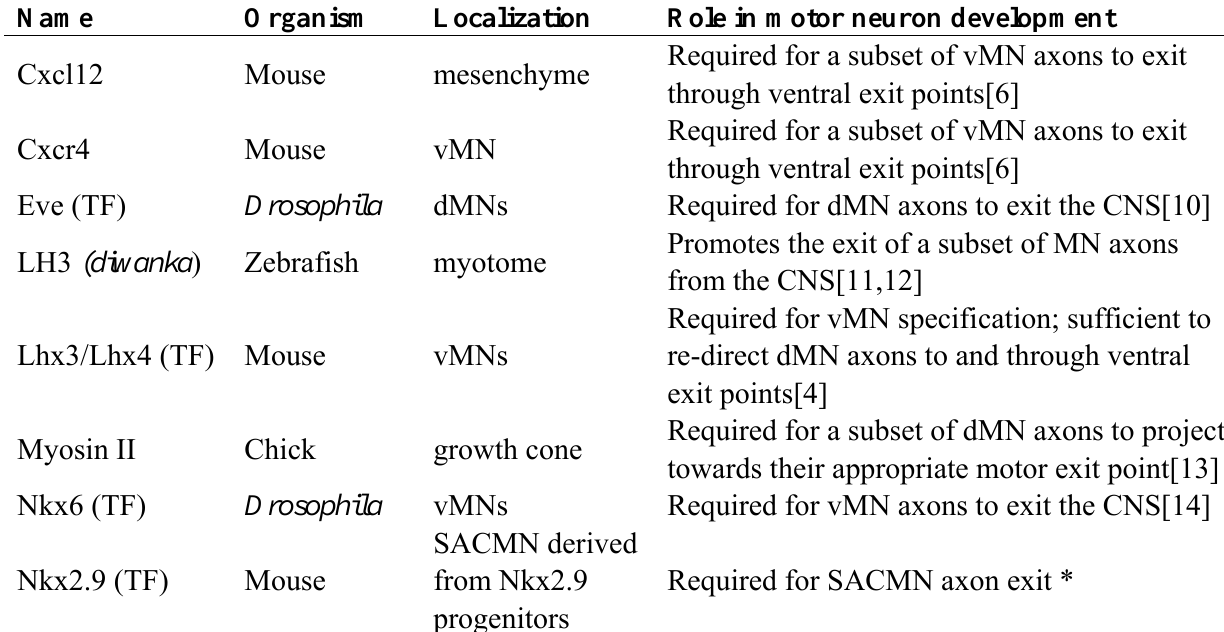
Table 1. Molecules localized to motor exit points and/or required for motor axon